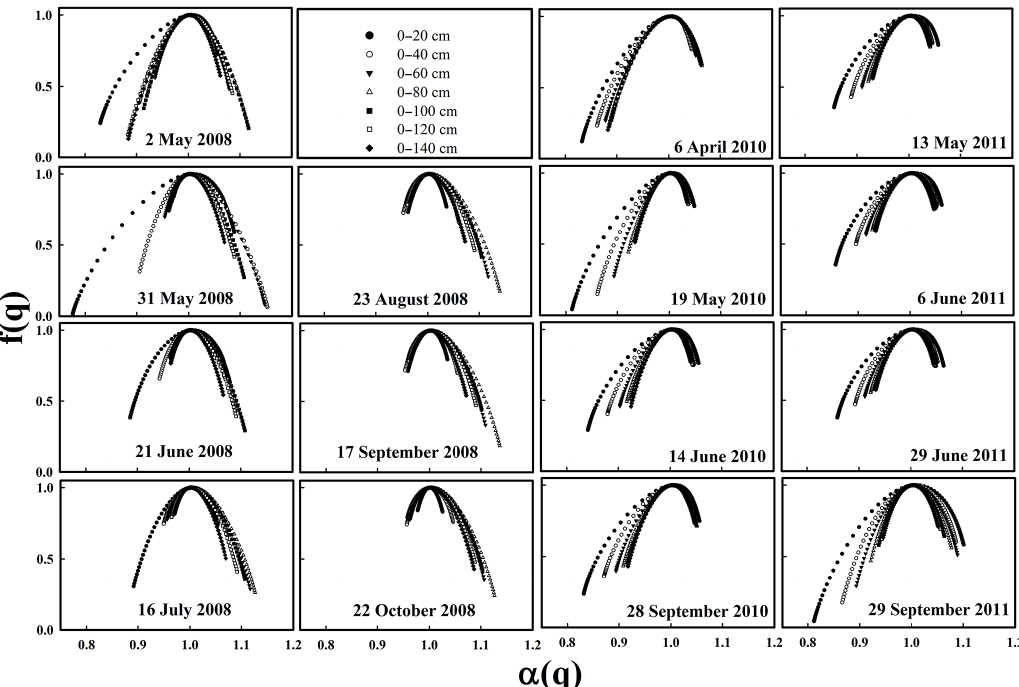
Figure 7. Multifractal spectra of soil water storage spatial series from surface to different soil layers (cumulative storage) at 20cm increment down to 140cm in 2008, 2010, and 2011 for a range of q ( − 15 to 15 at 0.5 increments).